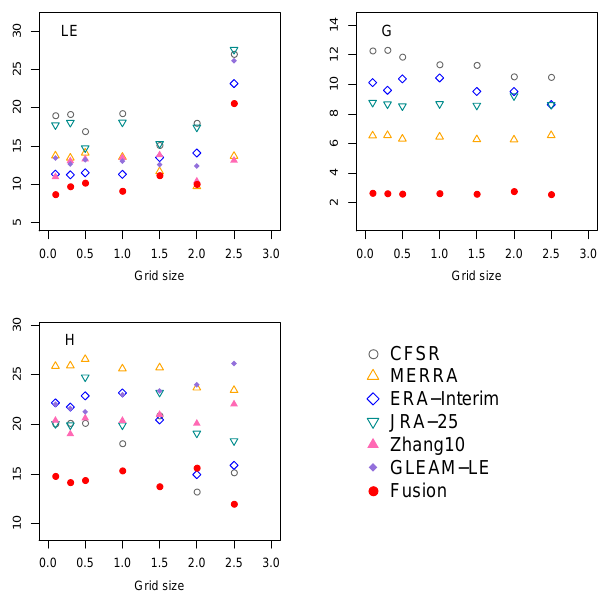
Figure 7. Comparisons of the RMSE_CV (Wm − 2 ) of latent heat flux (LE), ground heat flux ( G ), and sensible heat flux ( H ) at mul- tiple grid sizes ( ◦ ) from original data sets and fused data.